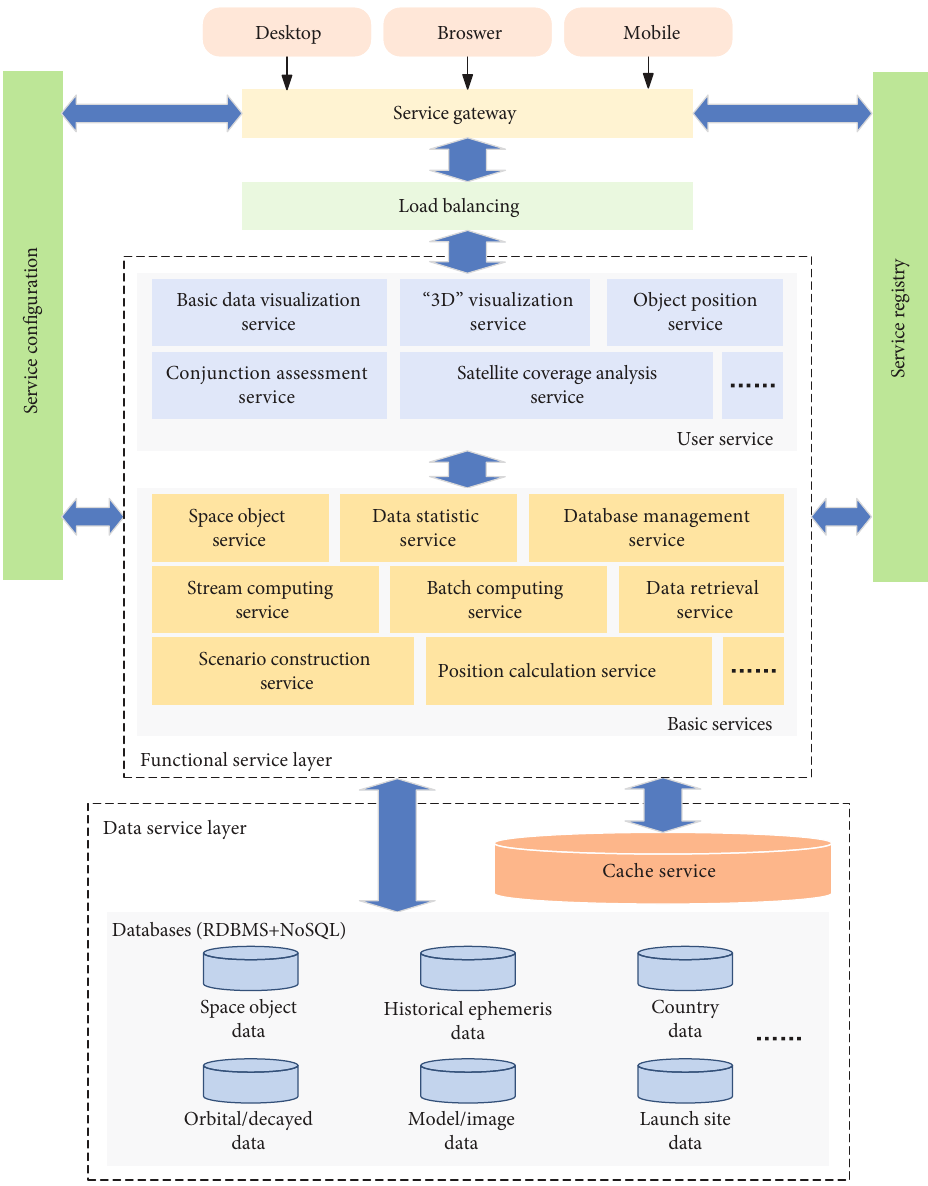
Figure 3: Platform architecture. Basic services and data service layer are provided by the platform; user services can be developed by users with a variety of algorithms and components. Databases include the RDBMS and NoSQL